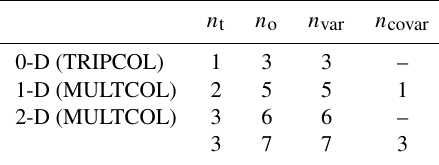
Table 1. The number of data source error variances n var and covari- ances n covar that can be estimated using different dimensions of the truth parameterisation n t , and number of data sources n o according to Eq.